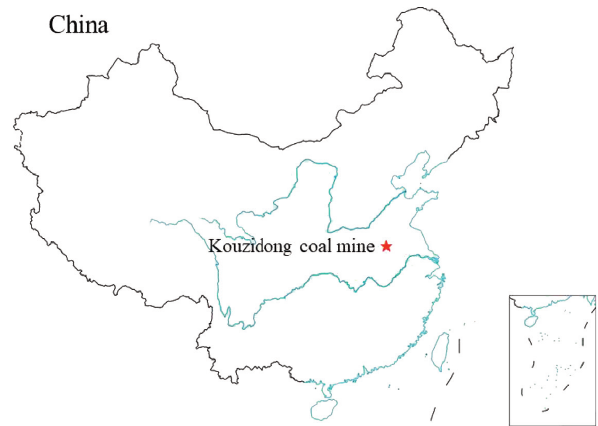
Figure 1: Location of Kouzidong coal